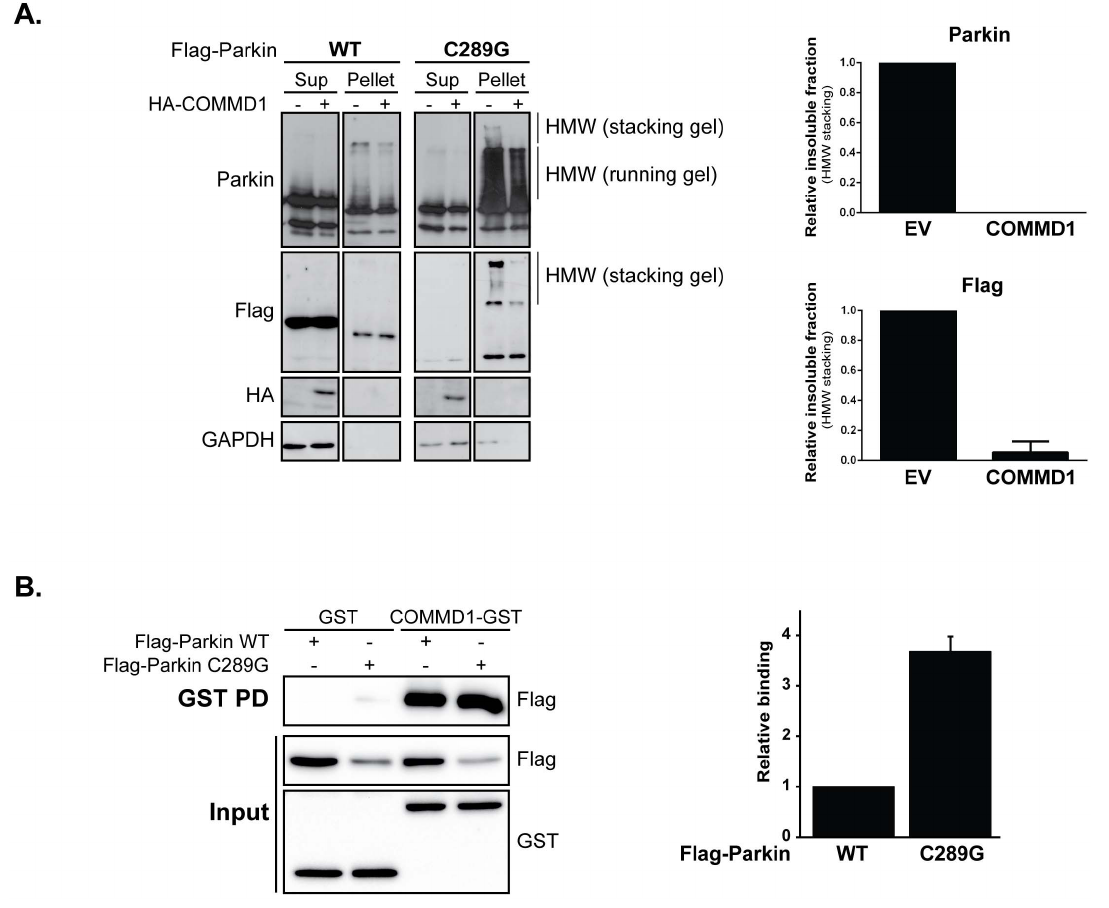
Figure 6. COMMD1 diminishes Parkin C289G aggregation. A. HEK293T cells were transfected with Parkin WT and C289G constructs alone, or in combination with HA-COMMD1. Supernatant (Sup) and pellet fractions were prepared as described in Experimental procedures. Immunoblotting was performed using indicated antibodies. Graphs represent relative fraction of insoluble Parkin proteins in absence or presence of exogenous COMMD1 (fractions quantified from both Parkin as well as Flag immunoblots). B. HEK293T cells were transient transfected with GST or COMMD1-GST alone in combination with Flag-Parkin constructs (WT and C289G). Cells were lysed, and GST fusion proteins were precipitated as described under Figure 1A. Immunoblotting was performed using indicated antibodies. Densitometric quantification of interaction strength between COMMD1 and Parkin WT versus C289G mutant, normalized for total Parkin expression (input). Binding of COMMD1 to Parkin WT was set at 1.